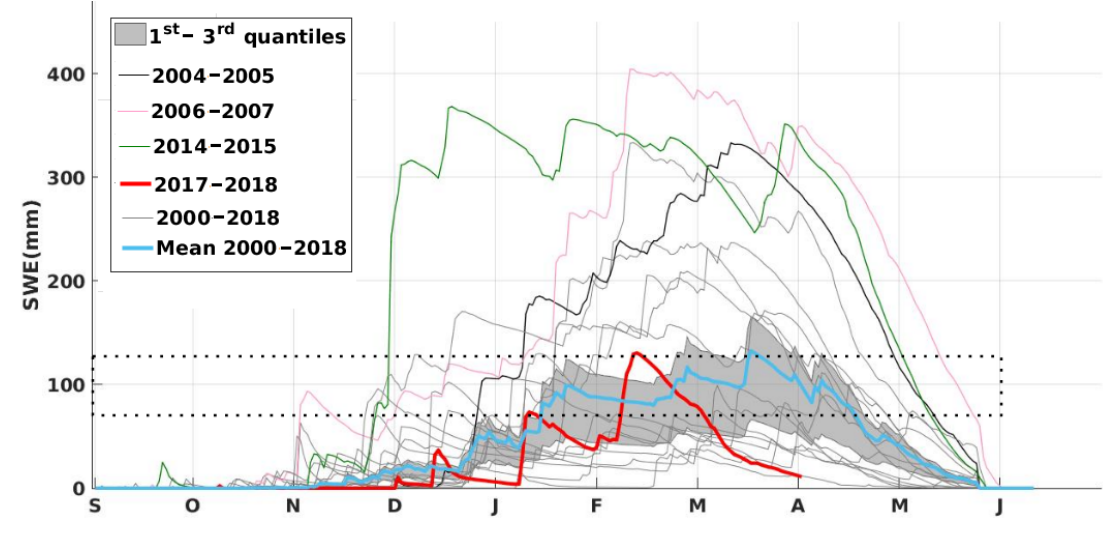
Figure 10. Evolution of the simulated SWE in the Ourika catchment from September 2000–April 2018. Each snow season from 1 September 2000–31 May 2017 was plotted at the daily time step as an individual gray line. The blue line shows the mean of these values, and the gray envelope indicates their first and third quantiles. The red line corresponds to the hydrological year 2017–2018. The year 2014–2015 is the green one, 2006–2007 pink and 2004–2005 black. Doted lines represent the interval 80 mm–100